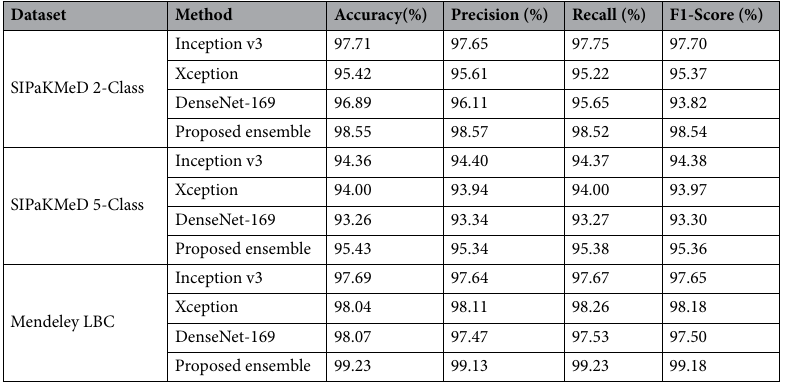
Table 6. Comparison of the classification performance of the base learners and their ensemble using the proposed